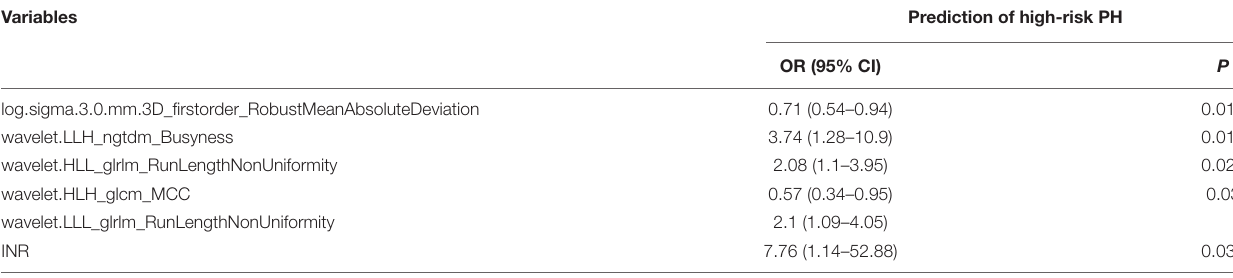
TABLE 2 | Univariate analysis for stratifying portal hypertension.